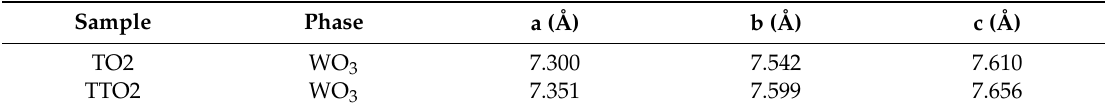
Table 2. Lattice parameters of TO2 and TTO2 for WO 3 phase.